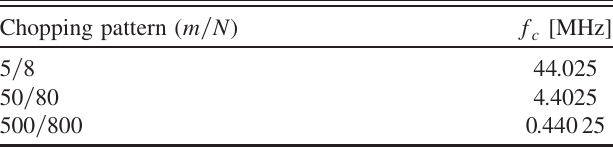
TABLE VII. Chopping patterns used in the beam dynamics simulations.